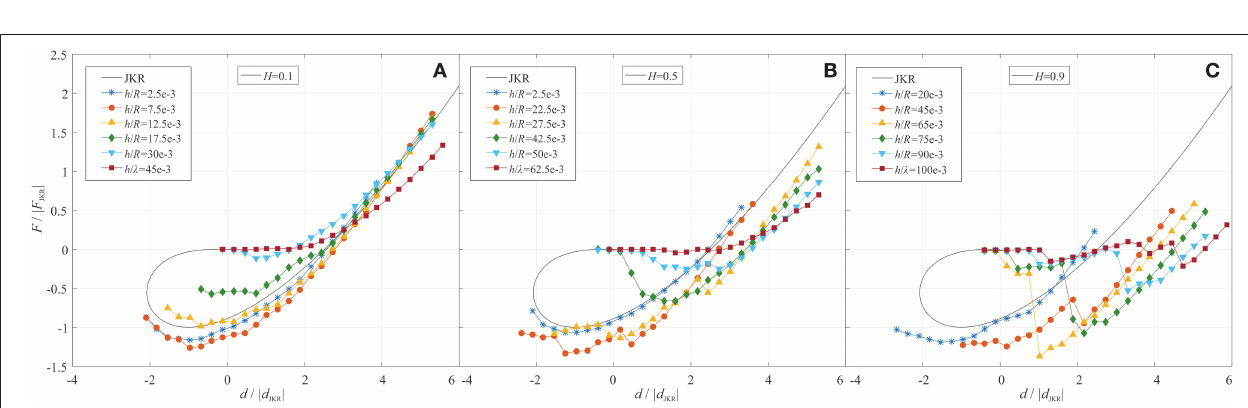
FIGURE 6 | Force-distance curves for different roughnesses and Hurst exponents (A) H